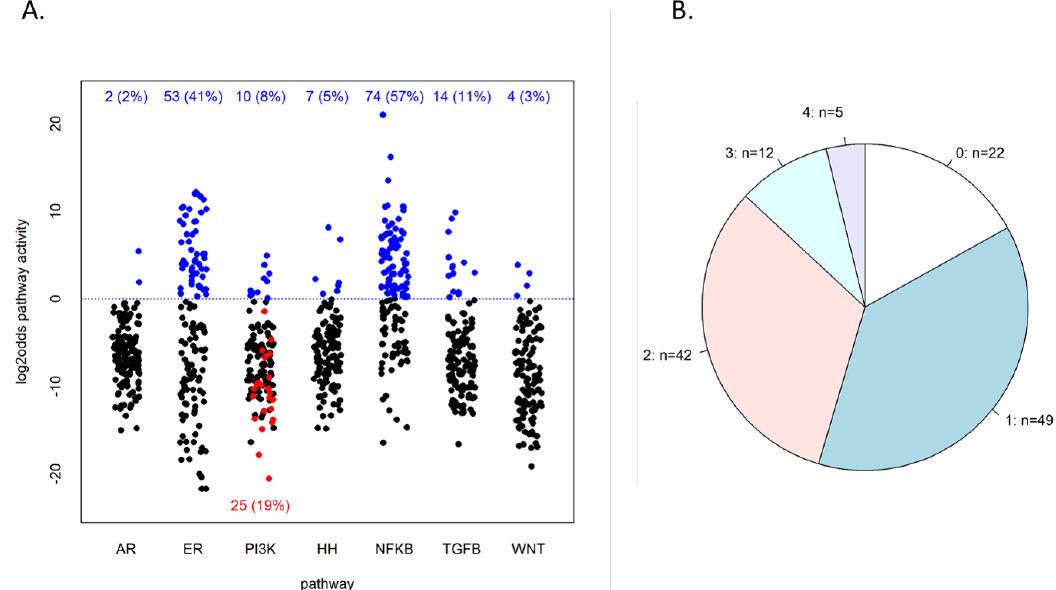
Figure 2. Resulting pathway activities of the study cohort. ( A ) Resulting log2odds values of pathway analysis on the 130 patient samples. The dotted blue line indicates the default threshold of 0 on the log2odds scale, and the numbers in blue at the top indicate the number of samples above this threshold. PI3K pathway log2odds score is taken as the inverse of the FOXO score, so samples below the line had a high FOXO score. Among the latter are 25 samples that also had an elevated SOD2 expression, indicated in red. PI3K active samples can be counted as those that had either low FOXO activity or FOXO-high- SOD2 -high (explained in the text and [4]). ( B ) Frequencies of the number of different pathways with high activity within the same sample; n = the number of samples that have 0,1, …, 4 pathways high, as indicated.